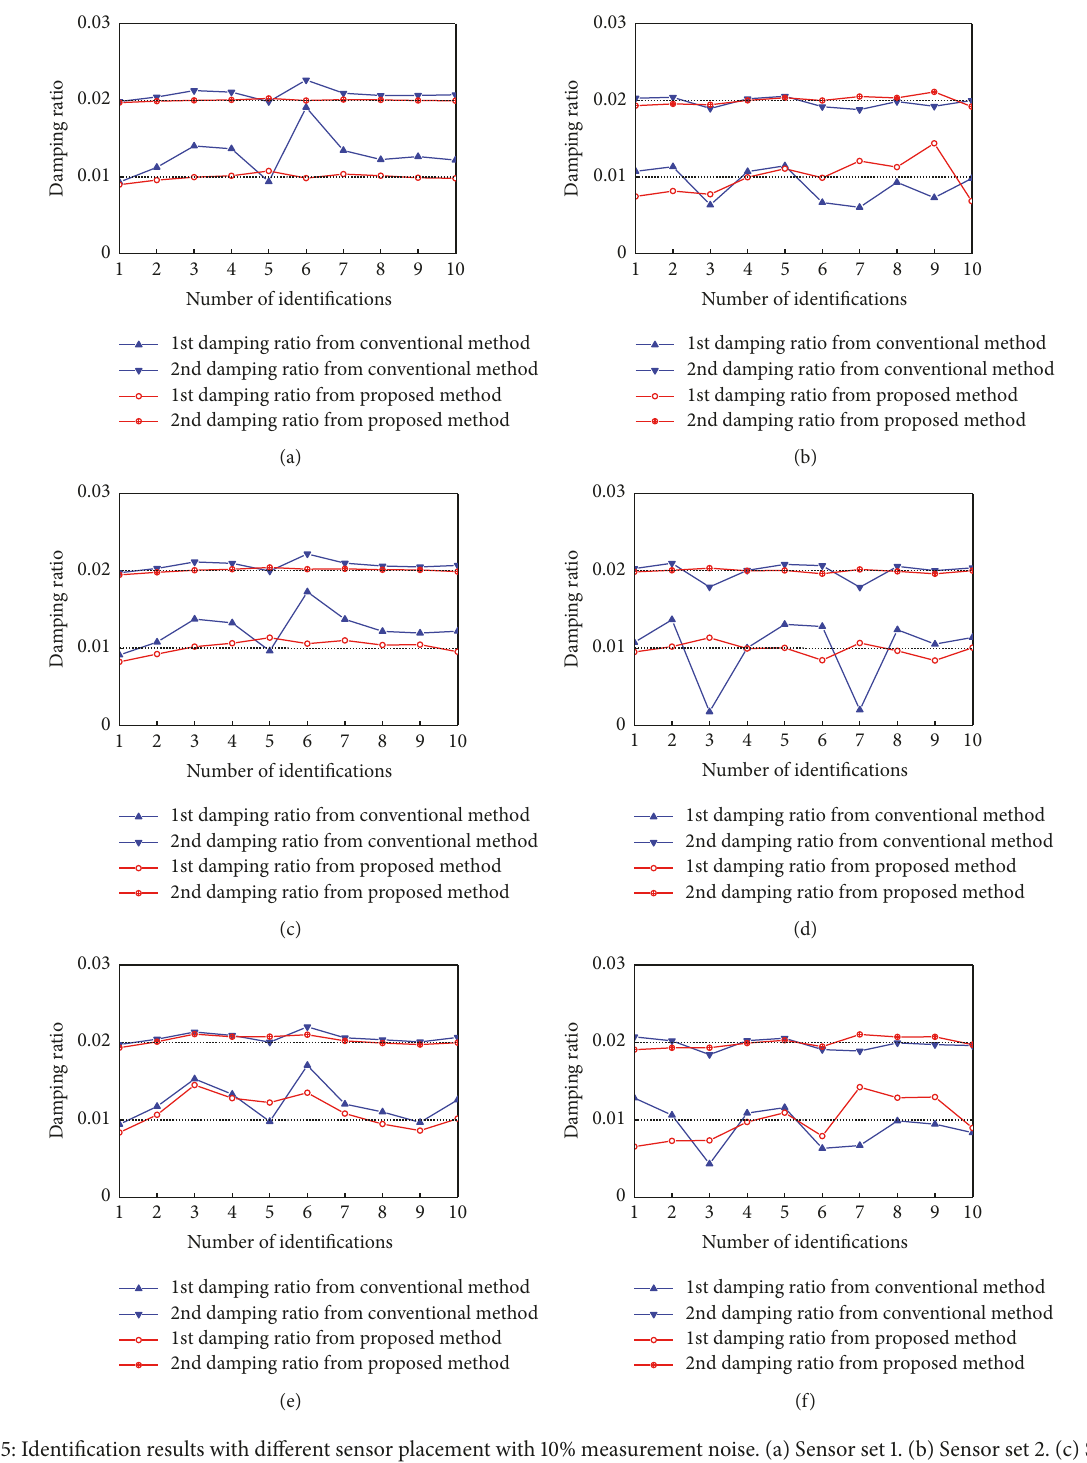
Figure 5: Identification results with different sensor placement with 10% measurement noise. (a) Sensor set 1. (b) Sensor set 2. (c) Sensor set 3. (d) Sensor set 4. (e) Sensor set 5. (f) Sensor set